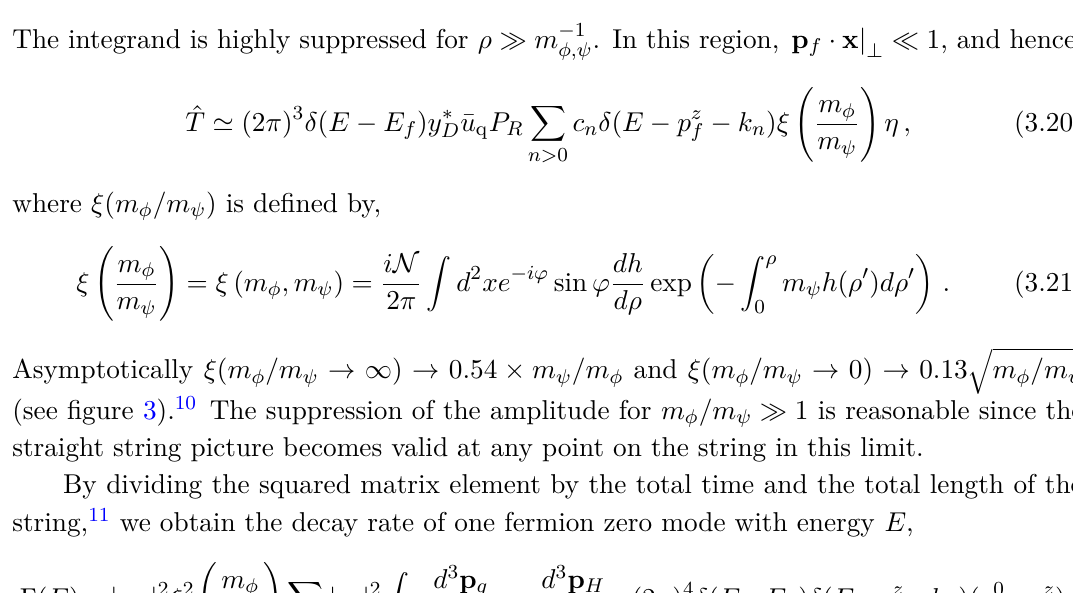
Figure 3 . The numerical estimation of the function ξ ( m φ /m ψ )